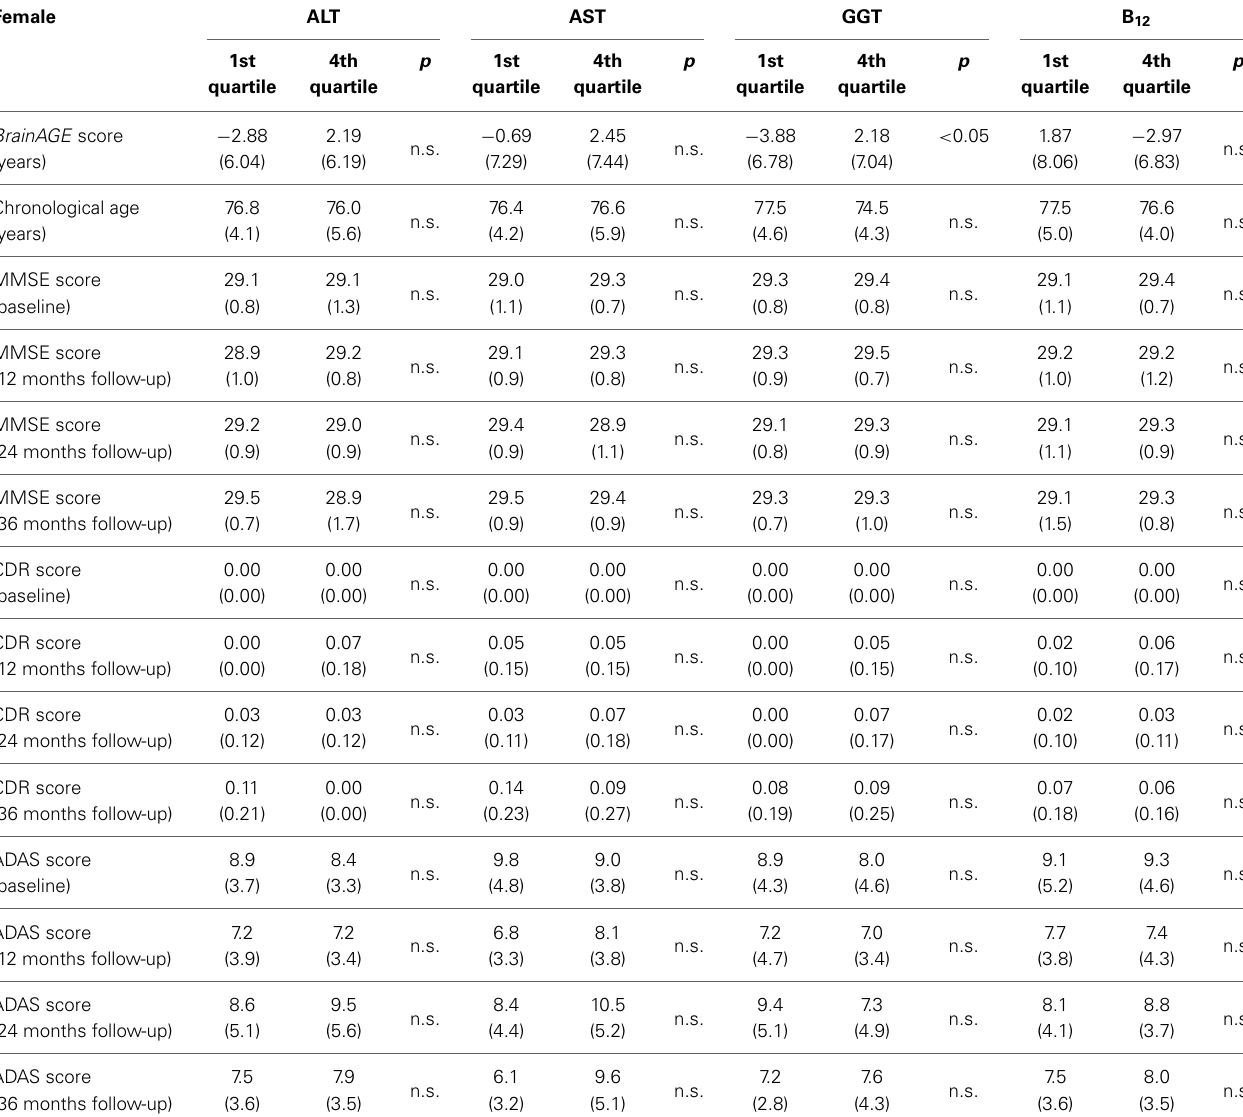
Table 6 | Means ( SD ) of BrainAGE scores, chronological age and cognitive scores in the 1st and 4th quartile groups of the four most significant physiological and clinical chemistry parameters within the female